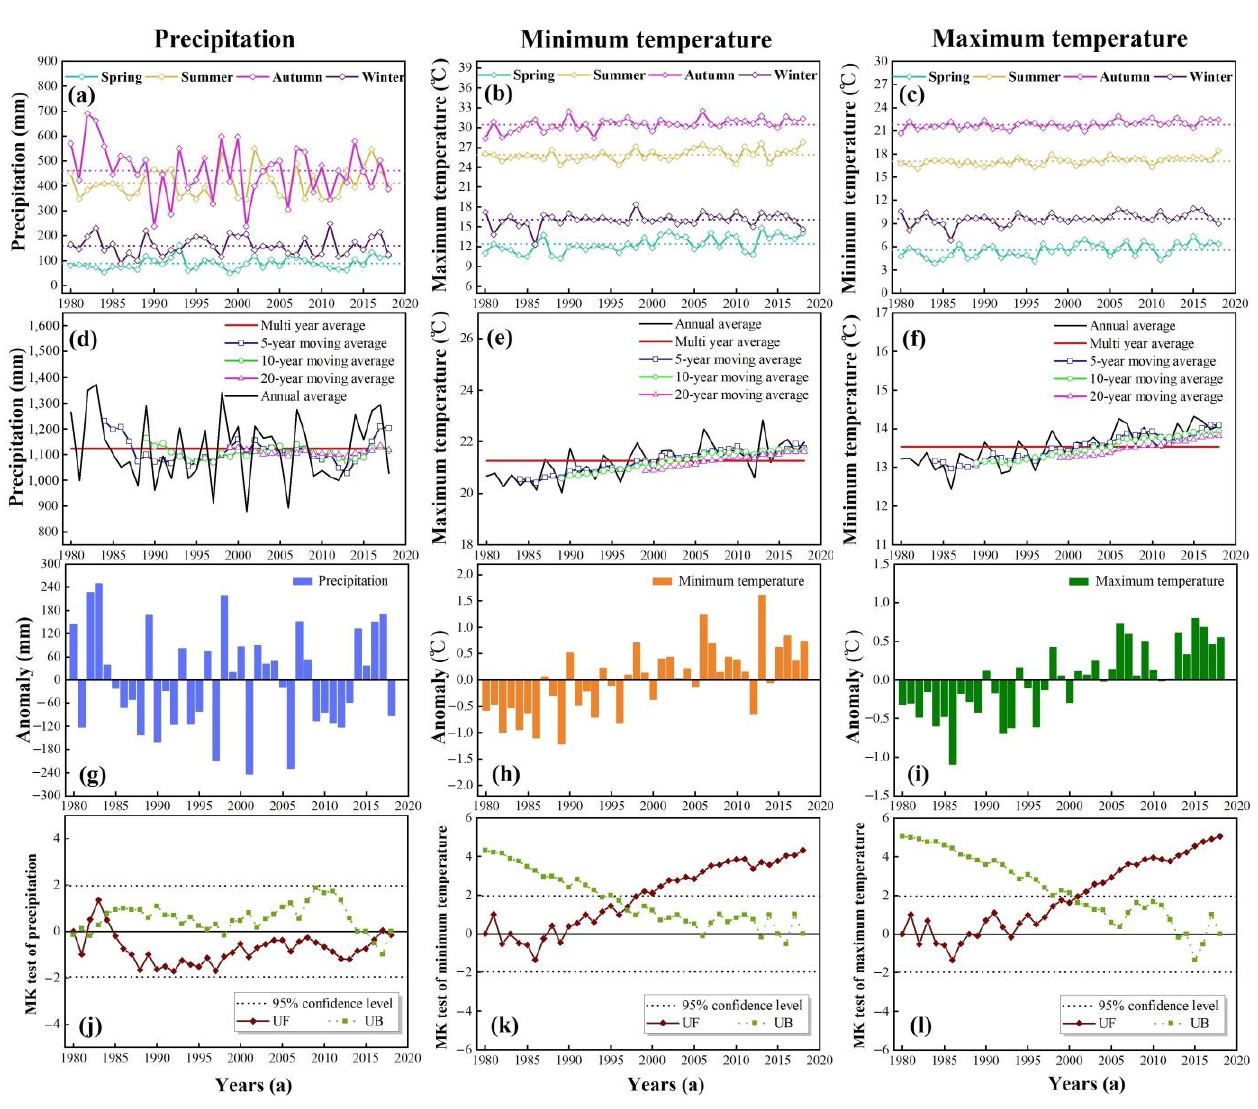
Figure 3. The season variation trend ( a – c ), moving average value ( d – f ), anomaly change ( g – i ) and Mann-Kendall test ( j – l ) of annual precipitation, minimum and maximum temperature.